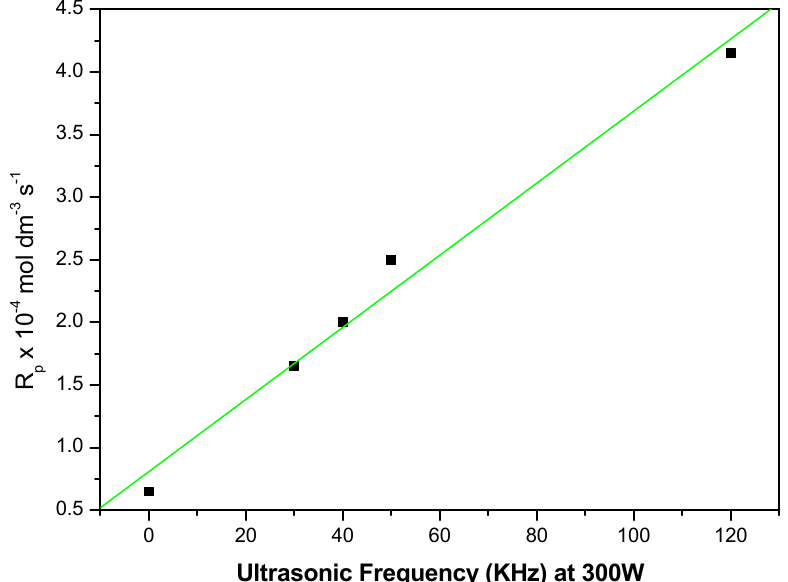
Figure 2. Influence of ultrasonic frequency variation on the rate of polymerization of MABE catalyzed by BPMACB: 2.00 × 10 − 2 mol·dm − 3 of PPS, 1.2 × 10 − 2 mol·dm − 3 of